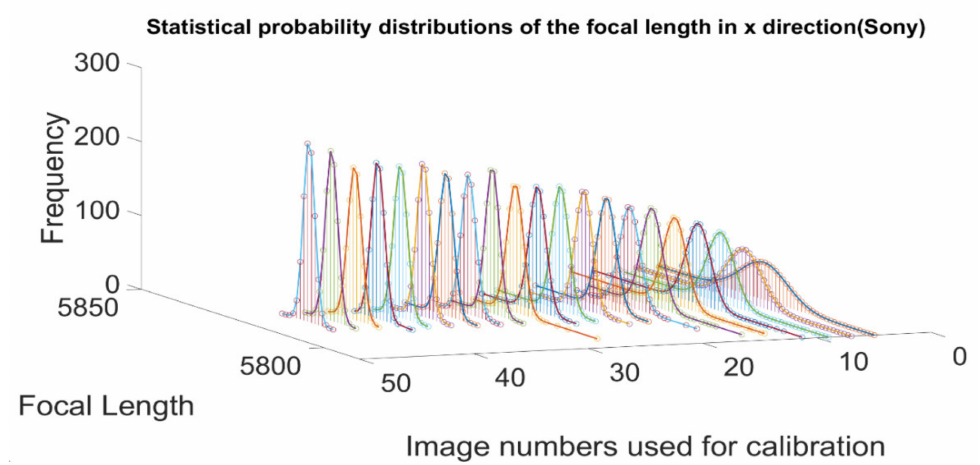
Figure 19. Gaussian fitting experiment results of the calibrated focal length in x direction for the Sony α 7R